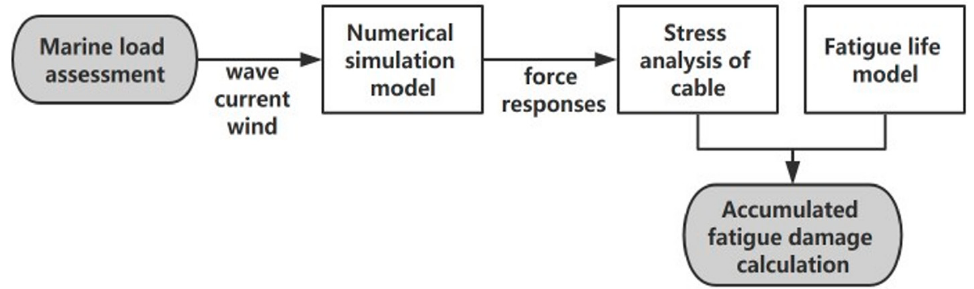
Figure 2. The typical life evaluation process for a wave energy converter cable.